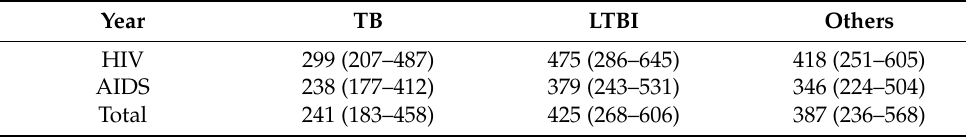
Table A2. CD4 cell count of people living with HIV in Guangxi